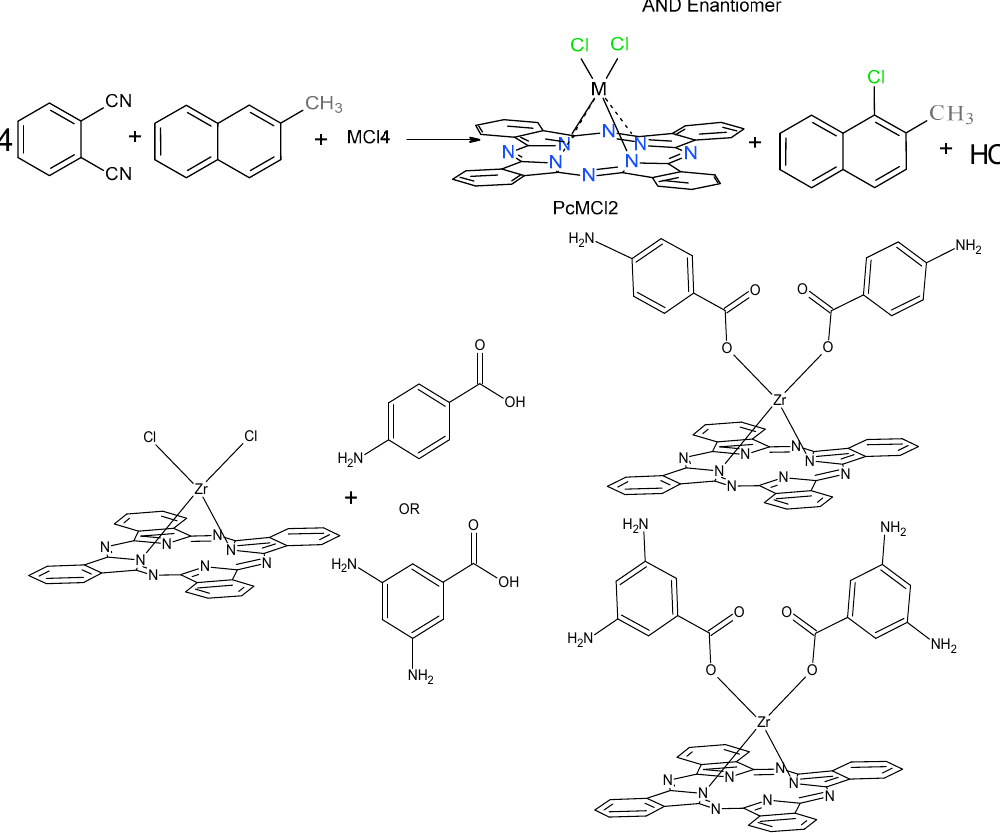
Figure 1. Synthesis of PcMCl 2 and bis (L) ZrPc complexes, where zirconium was used as metal ion (M) and 4-aminobenzoic acid (PABA) or 3,5-diaminobenzoic acid (DABA) were used as ligands (L). FTIR spectra of bis (PABA) ZrPc and bis (DABA) ZrPc and their composites, bis (PABA) ZrPc/GO